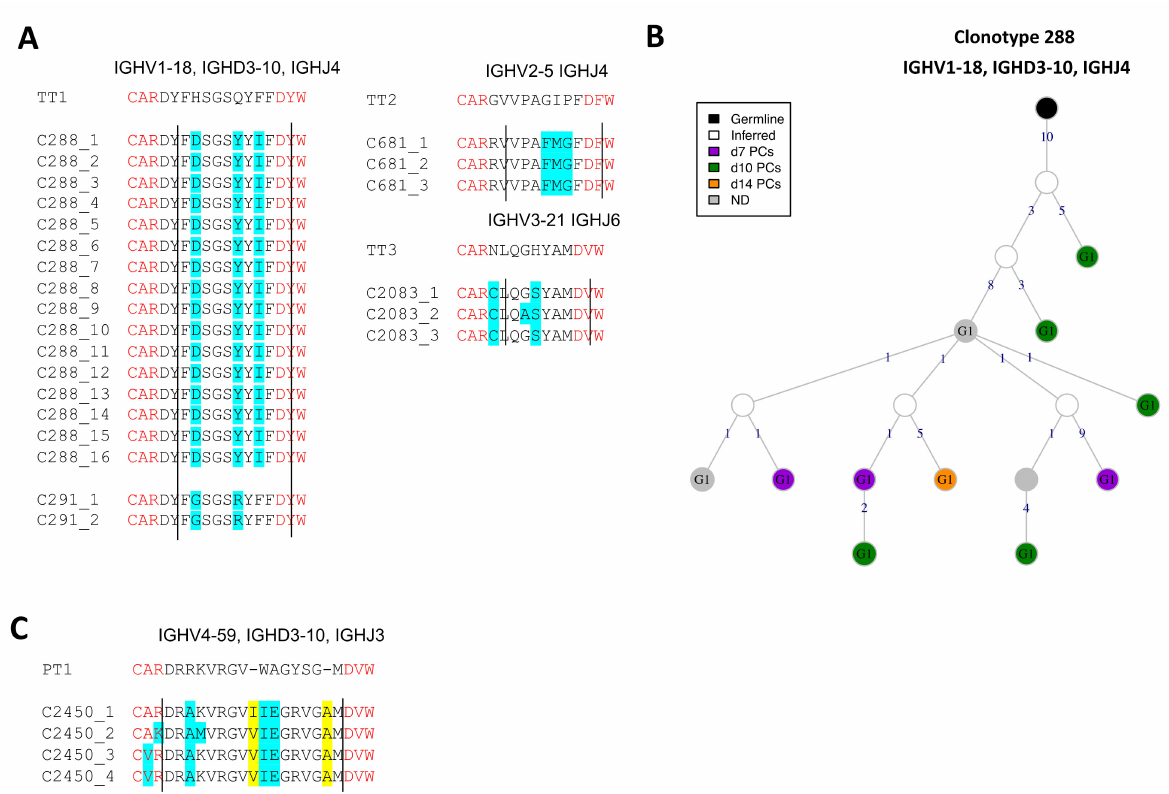
Figure 7. Toxoid-specific lineages upon Boostrix vaccination. ( A ) Highly conserved anti-tetanus toxoid BCR clonotypes. Four clonotypes with >80% identity are aligned to the anti-TT Ab query sequences. The changed residues are